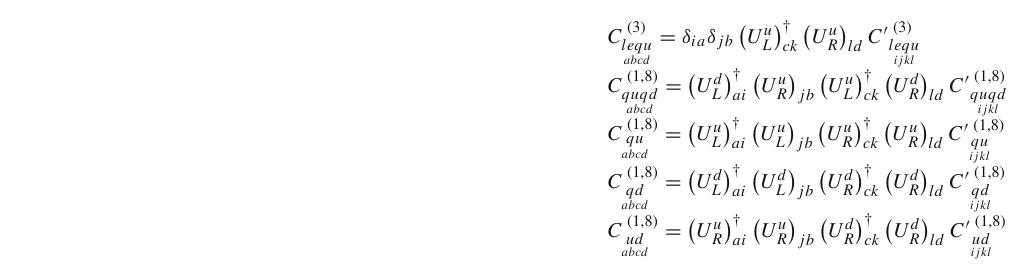
for the gauge basis in which the C (cid:4) coefficients are defined: for exam- = 1 , U d = V ( U d = 1 , U u = V † ) in the up ple, U u L / R L L / R L